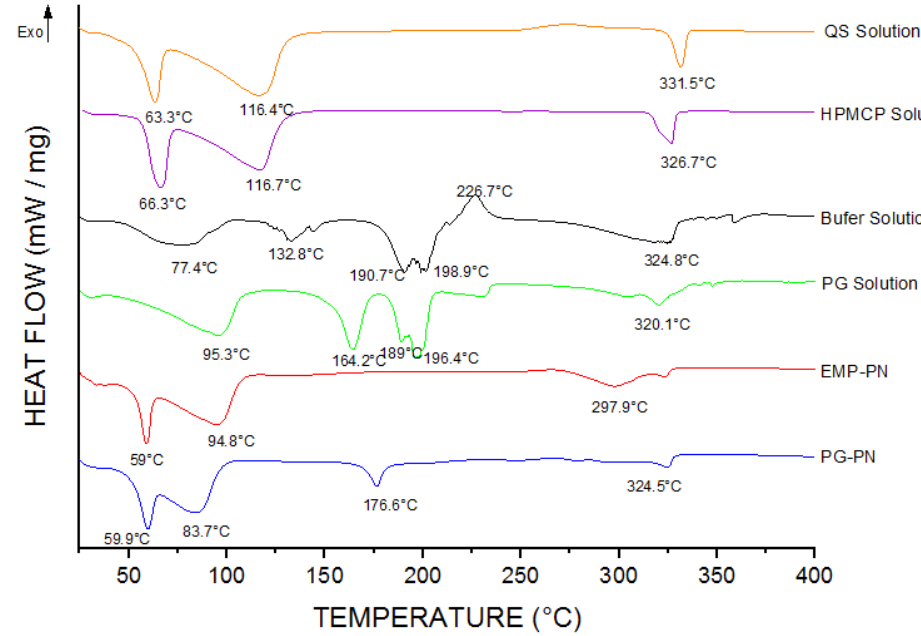
Figure 8. DSC curves of the polyelectrolytic nanocomposites and formulation components obtained in the heating range of 25–400 °C at a heat flow of 10 °C/min under dynamic nitrogen atmosphere flow (50 mL/min).